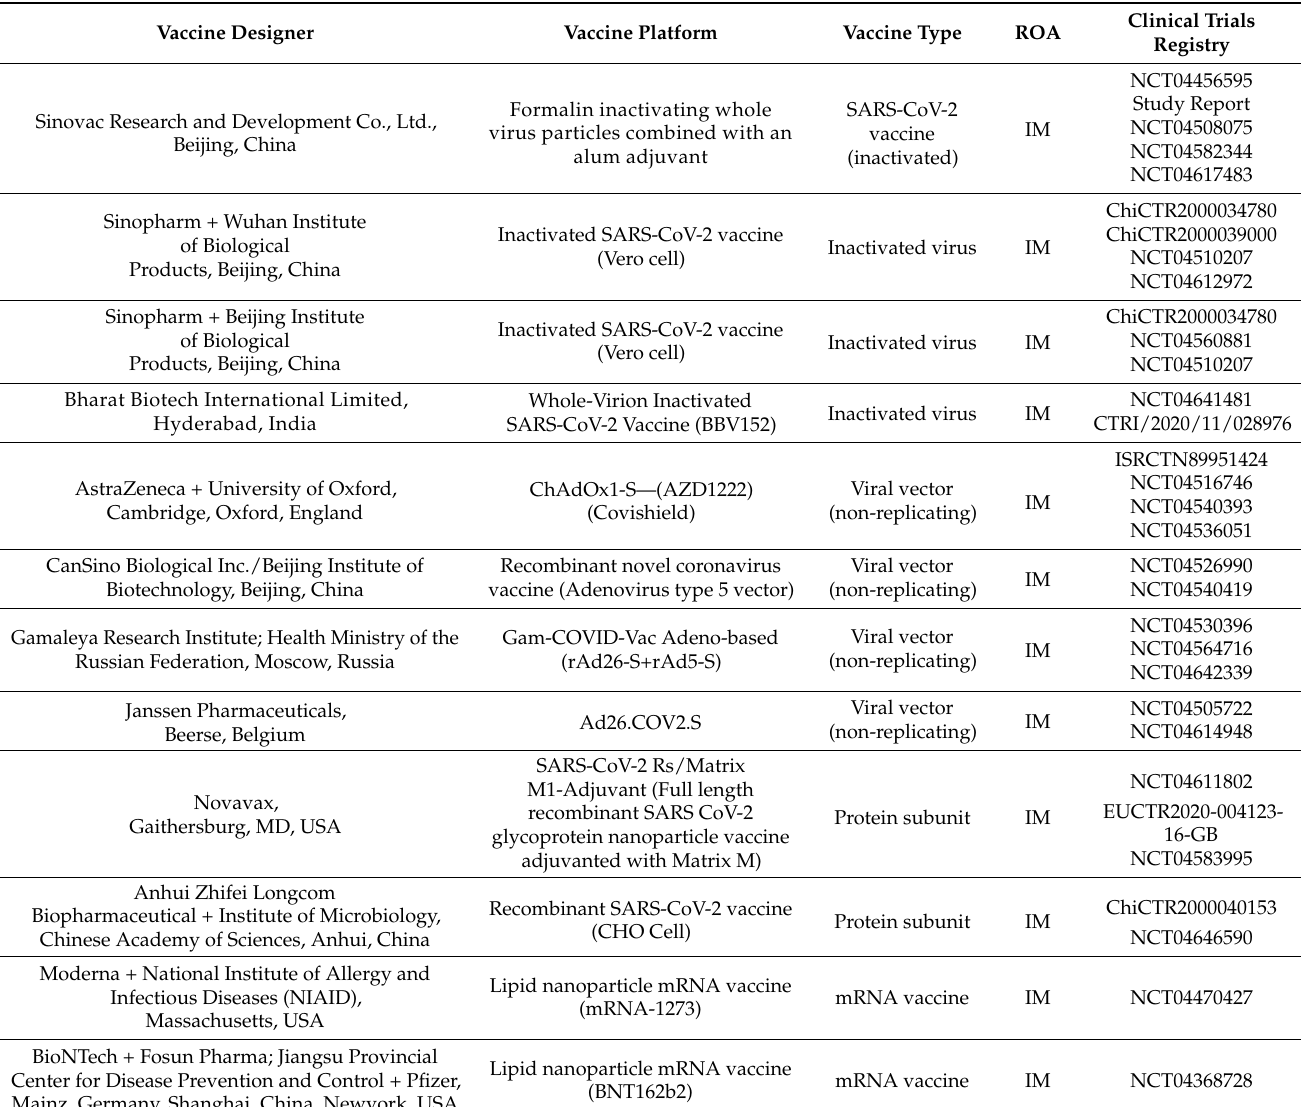
Table 3. COVID-19 vaccine candidates in Phase 3 clinical trials [181]. ROA—Route of Administration;